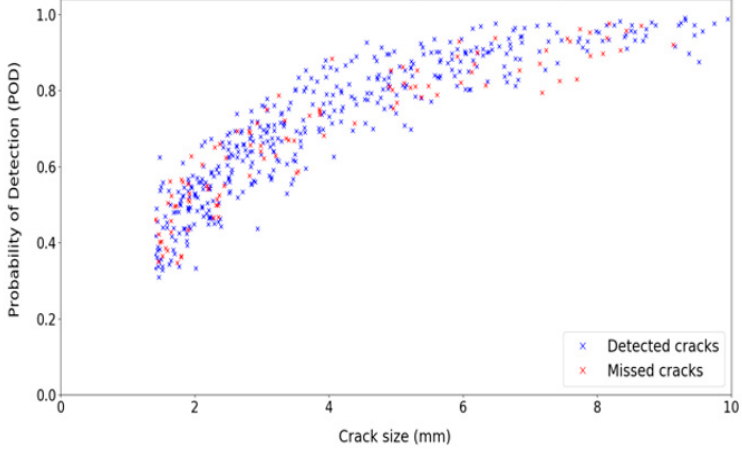
Figure 12. Detected/missed cracks obtained by implementing the detection criterion Figure 12. Detected / missed cracks obtained by implementing the detection